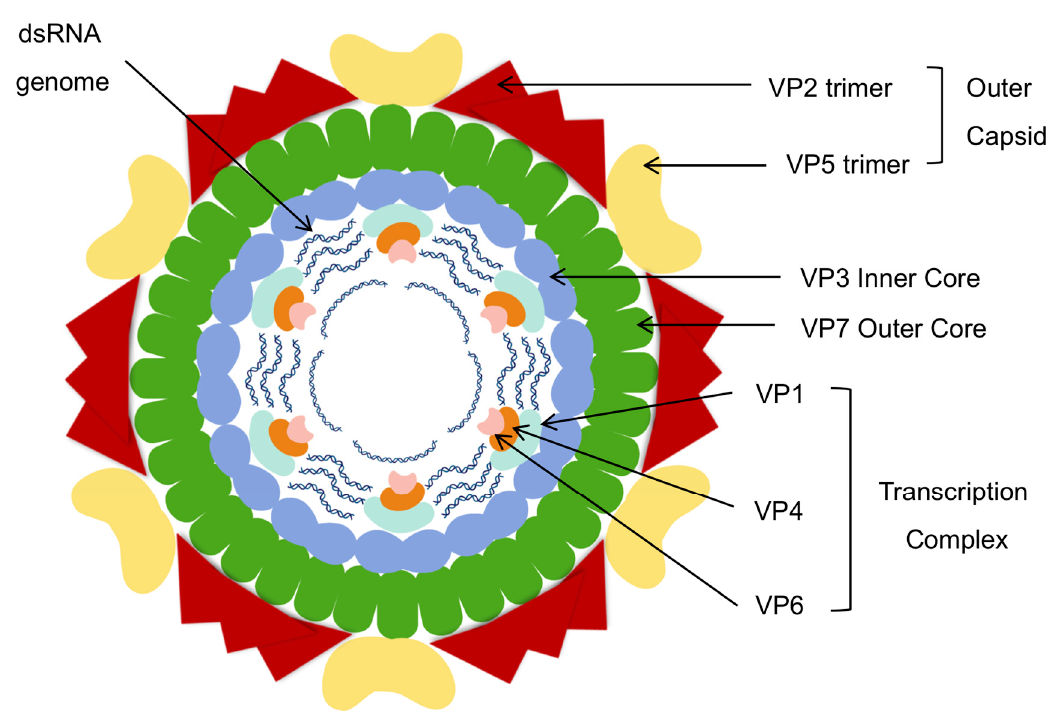
Figure 2. Schematic representation of the AHSV virion. The genome contains 10 segments of linear dsRNA coding for 12 proteins. The virion is non-enveloped with a triple capsid structure and is about 80 nm in diameter, enclosing the genome and transcription complexes. The inner core layer has T = 1 symmetry with each of the 60 units composed of a homodimer of VP3, while the outer core is composed of 260 trimers of VP7 and has T = 13 icosahedral symmetry. The outer capsid layer consists of 120 globular trimers of VP5 and 60 triskelion-shaped spikes of VP2. Image created with Biorender.com.